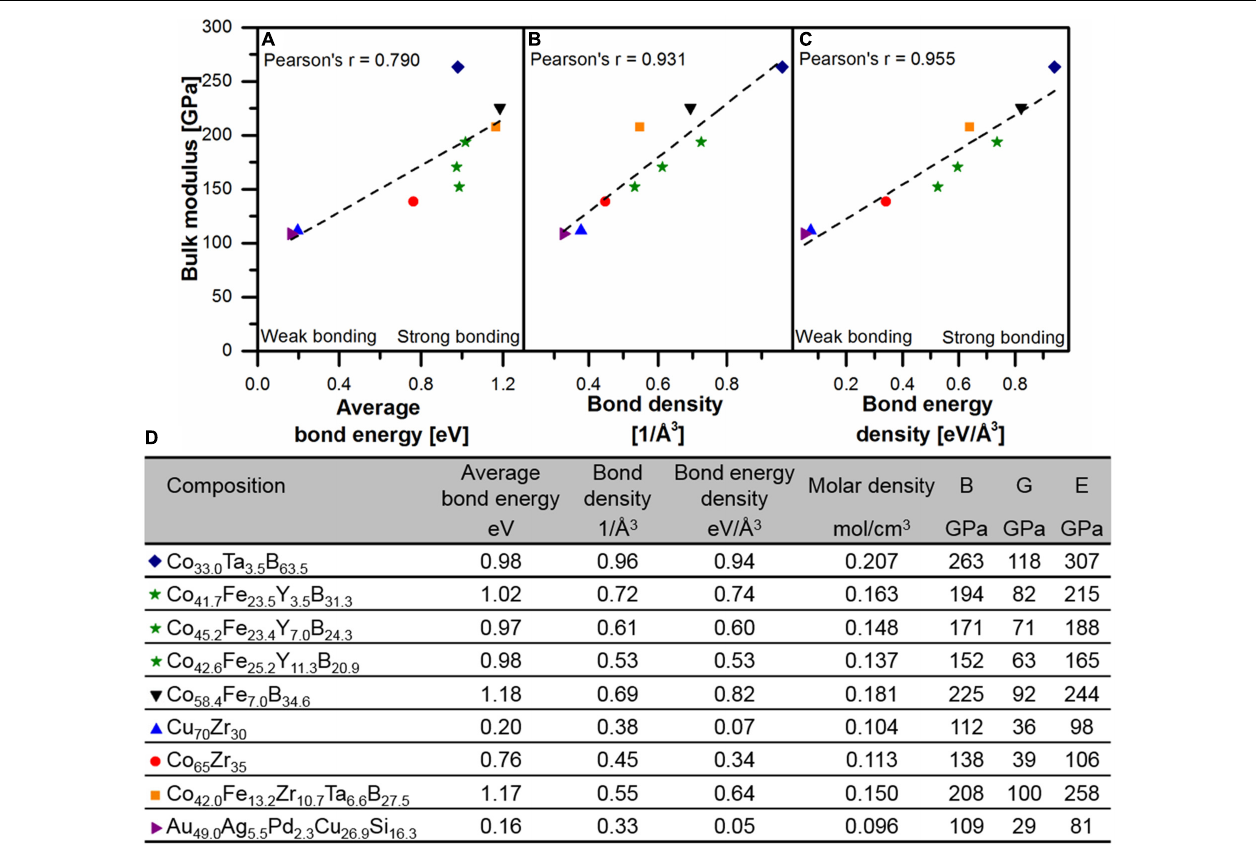
FIGURE 3 | Comparison of bulk modulus as a function of average bond energy (A) , bond density (B) and bond energy density (C) based on ab initio calculations. The table (D) summarizes chemical composition, average bond energy, bond density, bond energy density, molar density, bulk, shear and Young’s modulus of data points shown in (A–C) . B is the bulk modulus, G shear modulus and E Young’s modulus. © IOP Publishing. Reproduced from Schnabel et al. (2017) with permission from IOP. All rights reserved.